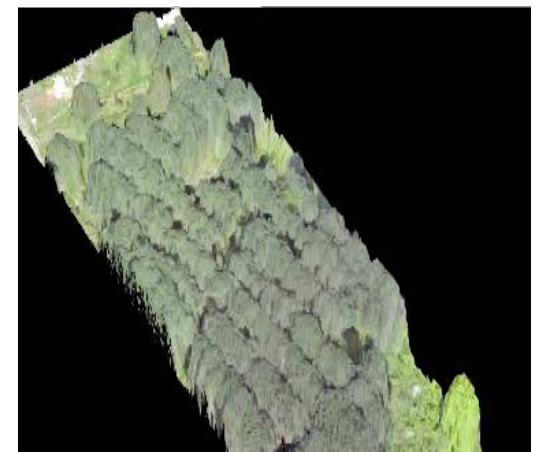
Figure 3. Orthophoto of the study area draped over the CHM